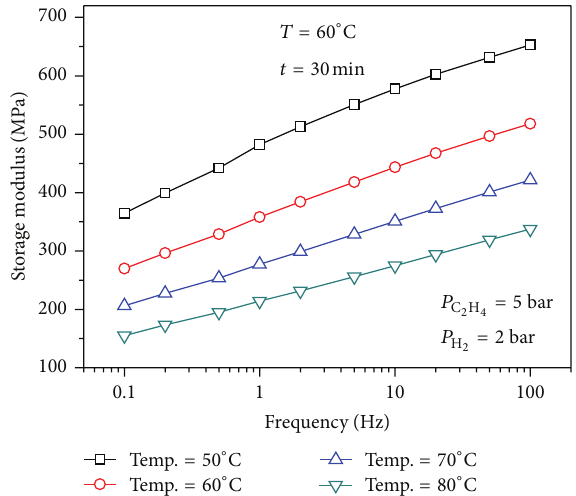
Figure 1: Dynamic temperature step/frequency sweep for copoly- mer sample 2 synthesized at 𝑃 temperature = 60 ∘ C, and 𝑡